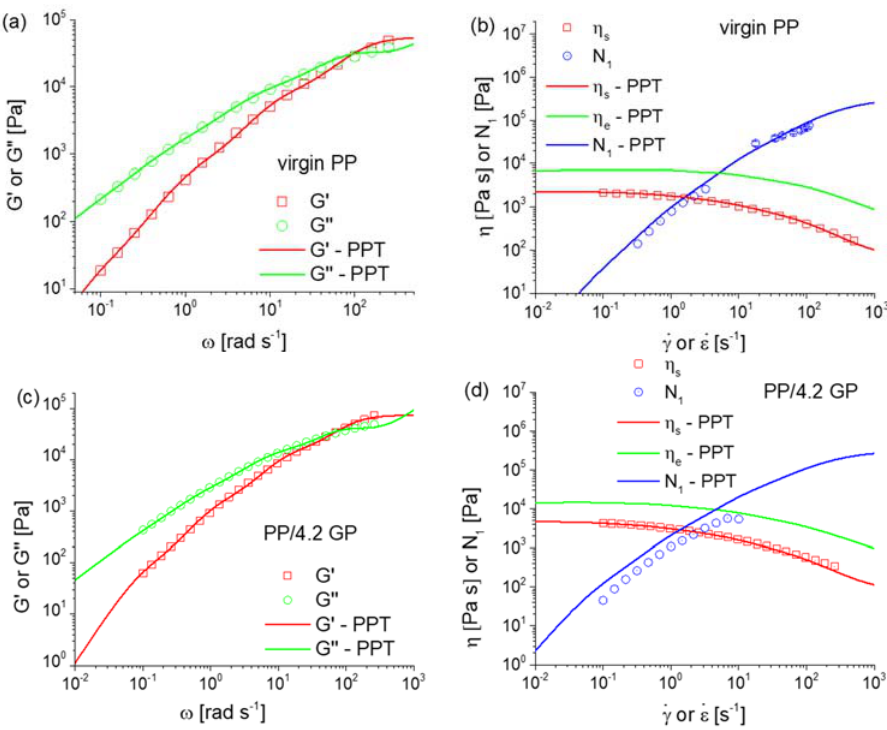
Figure 3. Experimental rheological data including the storage modulus G ′ , the loss modulus G ″ , the shear viscosity 𝜂 (cid:3046) and the first normal stress difference N 1 . ( a ) G ′ and G ″ for PP, ( b ) 𝜂 (cid:3046) and N 1 for PP, ( c ) G ′ and G ″ for PP PP composite; ( d ) 𝜂 (cid:3046) and N 1 for PP composite; composite with a graphite filler content of 4.3% (PP/4.3GP). The curves indicate rheological data via PTT model (parameters in Table 1, also including the elongational viscosity η e . For the PP/9.3GP composite, the N 1 data at the high shear rate range are measured by means of the exit pressure method from Tang et al.